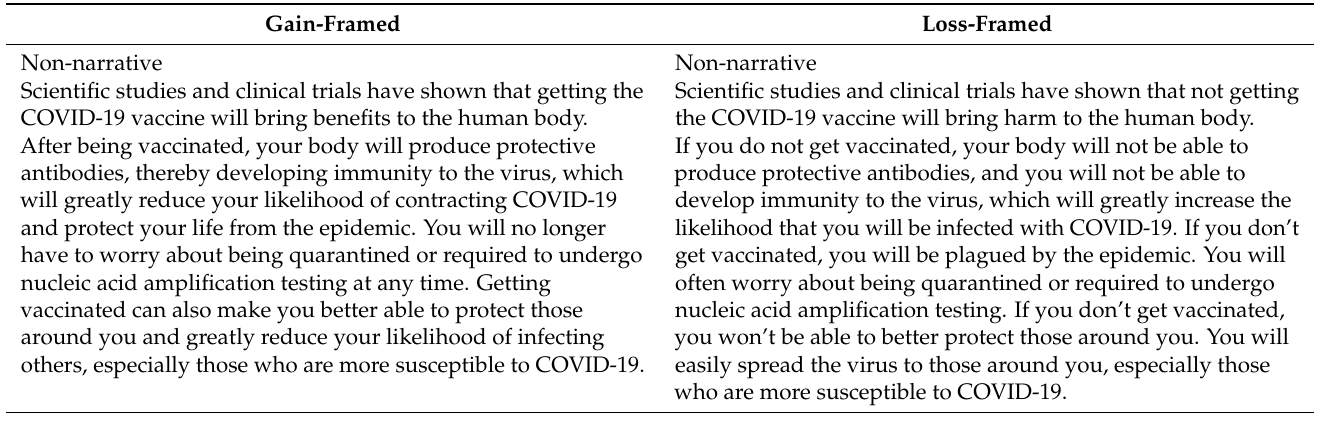
Table 1. Message stimuli in experiment